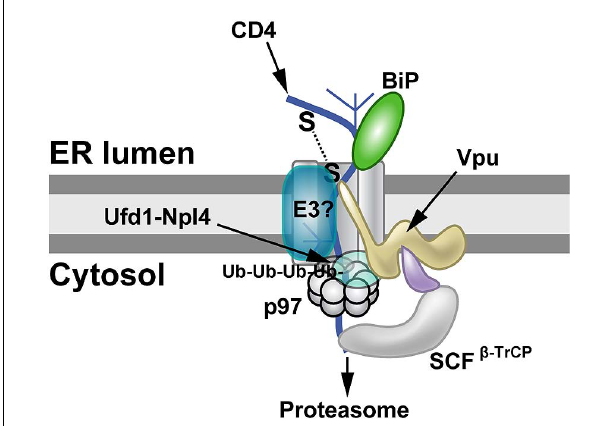
FIGURE 3 | Proteasomal targeting of CD4 by HIV-1Vpu. The transmembrane proteinVpu recruits the E3 ligase complex SCF β − TrCP . Knockdown of both β -TrCP1 and β -TrCP1 (shown to be contactingVpu) can prevent CD4 degradation, suggesting that either F-box protein can provide a functional SCF complex for ubiquitination (Magadán etal., 2010). Another E3 ligase (E3?) also may be involved.The p97 ATPase with the adapters Ufd1 and Npl4 are required for CD4 degradation, but the UFD1L protein recognizes polyubiquitinated CD4. Lysine and serine/threonine residues in the CD4 cytosolic tail are needed for ubiquitination (Magadán etal.,